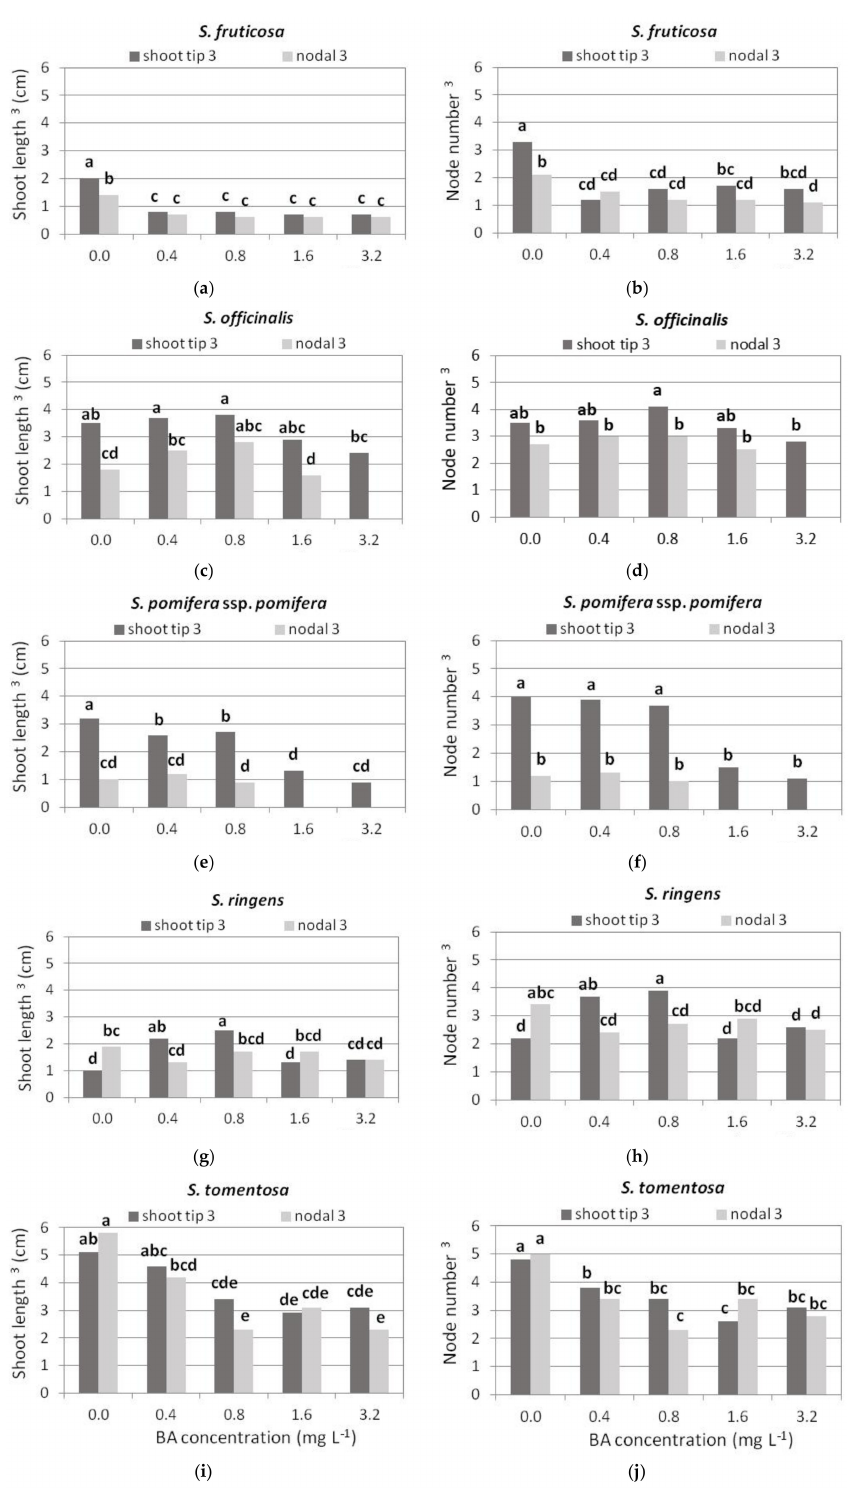
Figure 7. Effect of BA concentration on shoot length (cm) and node number per shoot, produced using shoot tip or single node (nodal) explants of each Salvia species shown cultured on MS medium, either hormone free or supplemented with 0.01 mg L − 1 NAA and BA concentration marked. Only normal shoots 3 were recorded. Mean separation using Student’s t , p ≤ 0.05; means followed by the same letter are not significantly different at p ≤ 0.05, n = 30. 3 Normal shoots per